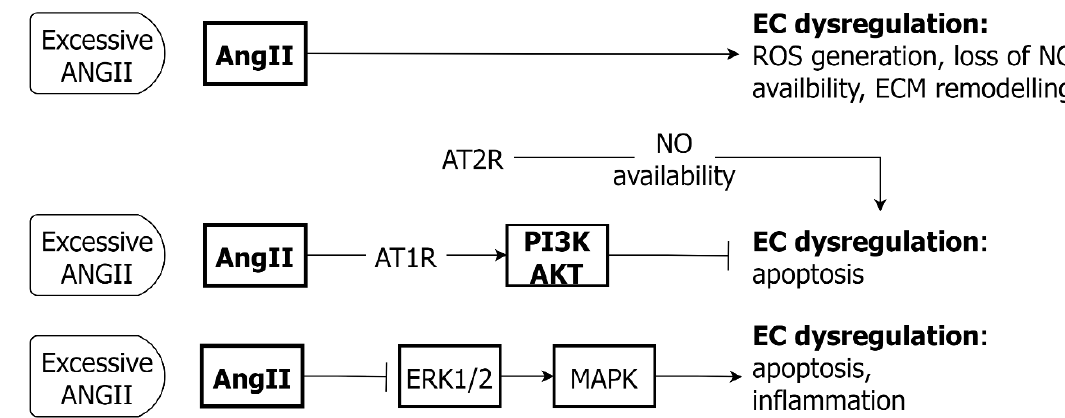
Figure 10. Summary of the mechanisms of ANGII signaling pathways in EC. Excessive ANGII will result in EC dysregulation through the generation of ROS, result in inflammation, ECM remodeling and apoptosis.